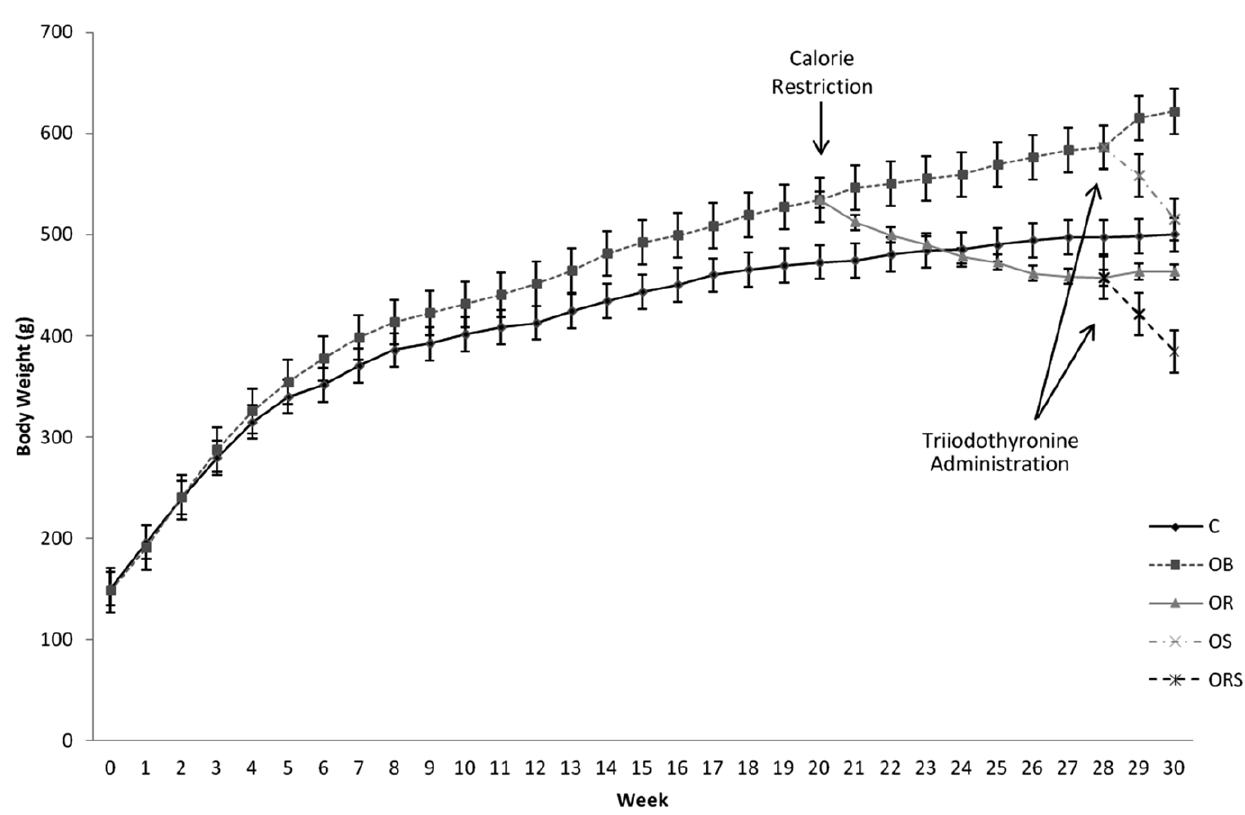
Figure 2. Body weight development, in grams, during a 30-week experimental period. C, control; OB, obese; OR, calorie-restricted obese; OS: obese given T 3 at 25 m g/100 g BW; ORS: calorie-restricted obese rats given T 3 at 25 m g/100 g BW. Data are expressed as means and 95% confidence interval.